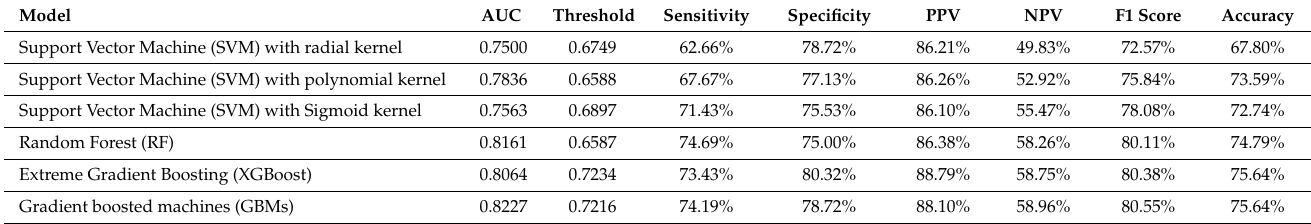
Table 2. Comparison of various models’ performance for predicting in-hospital mortality using test data.